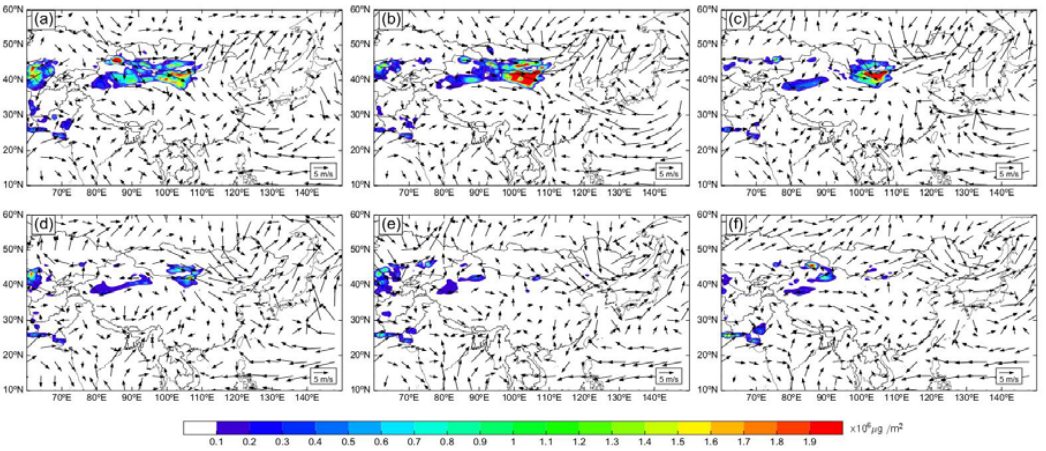
Figure 12. Spatial distribution of dust aerosol emission on 2–7 May 2017. The wind field is 10 m above